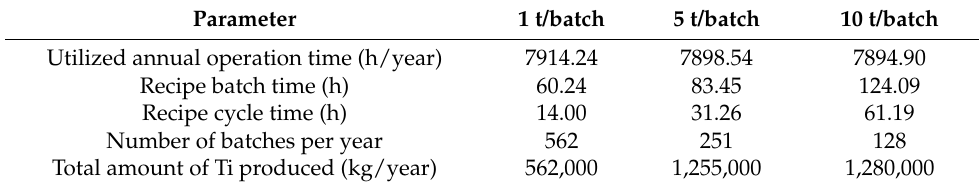
Table 2. Overall process parameters for process simulation for different production scales of Ti powder.